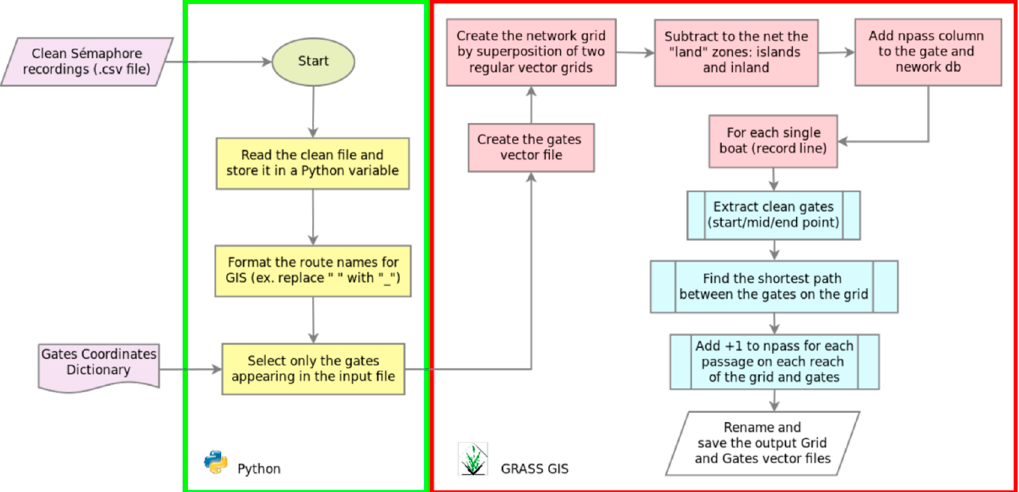
Figure 5. v.createRoutes.py flowchart: the first part (in Python, bordered in green) concerns the data preparation; the second part (in GRASS GIS, bordered in red) relates to data spatialization.